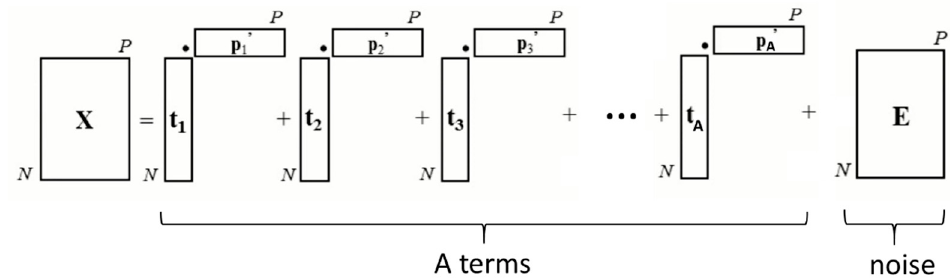
Figure 2. Writing of the matrix X of the initial data according to the PCA model.